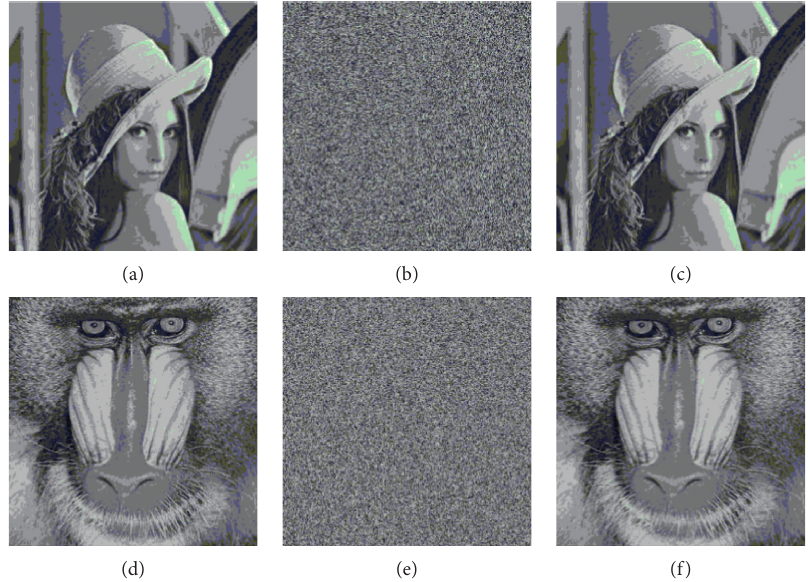
Figure 11: (a) Original image Lena. (b) Encrypted image Lena. (c) Decrypted image Lena. (d) Original image Baboon. (e) Encrypted image Baboon. (f) Decrypted image Baboon.